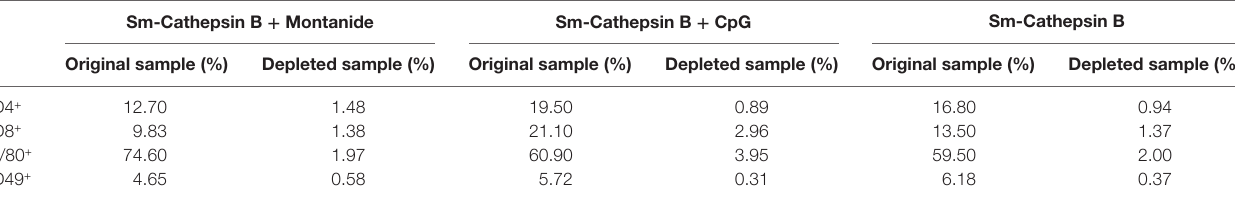
TaBle 1 | Depletion of cell populations in Schistosoma mansoni Cathepsin B (Sm-Cathepsin B) + Montanide, Sm-Cathepsin B + CpG, and Sm-Cathepsin B